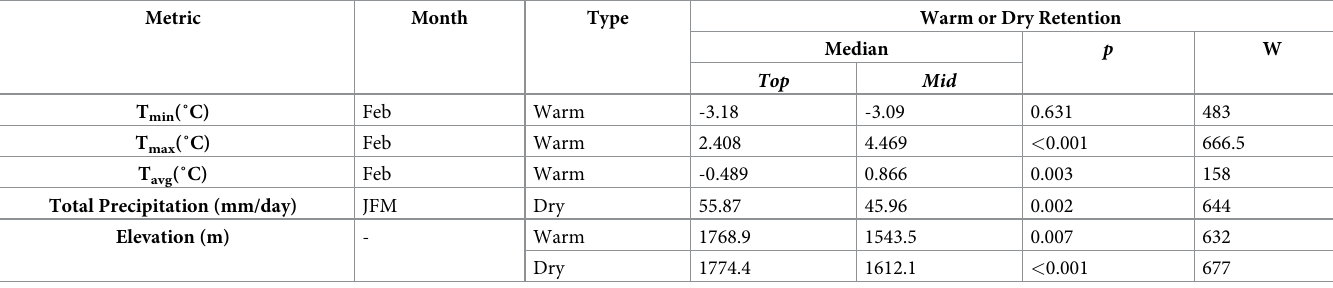
Table 3. Temperature, precipitation and elevation influences on warm or dry